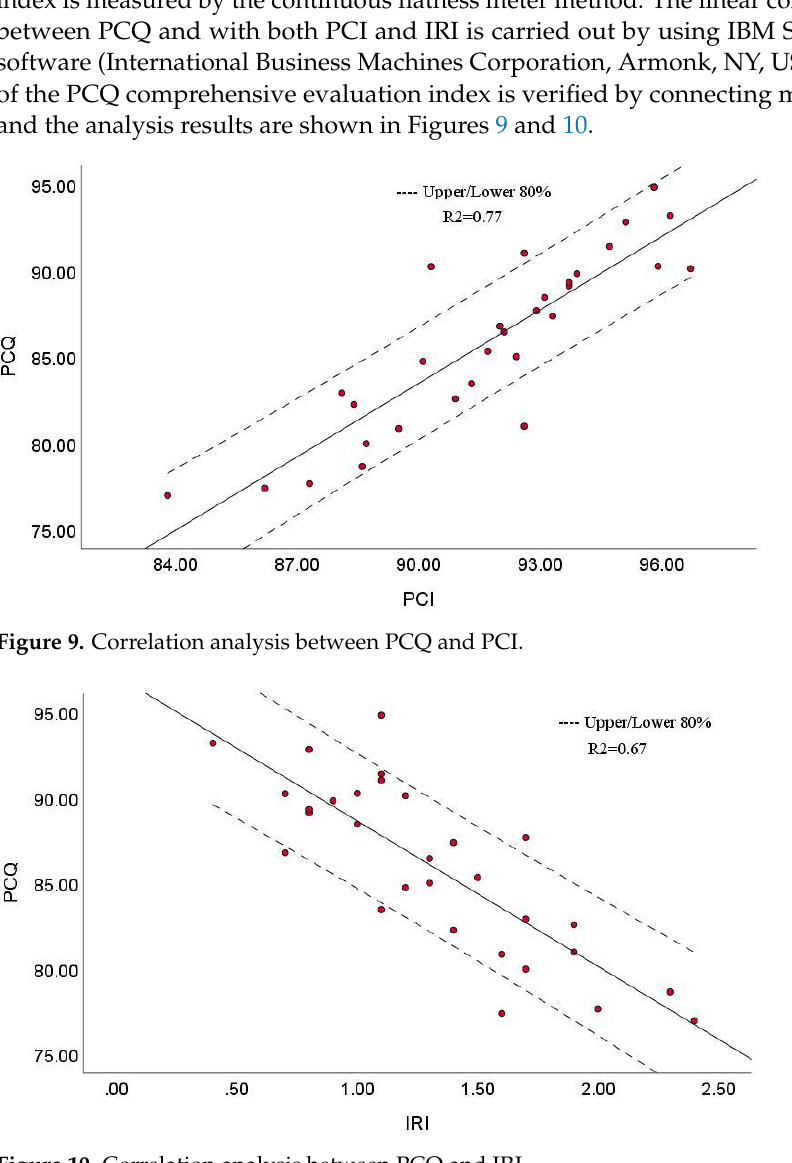
Figure 10. Correlation analysis between PCQ and IRI.